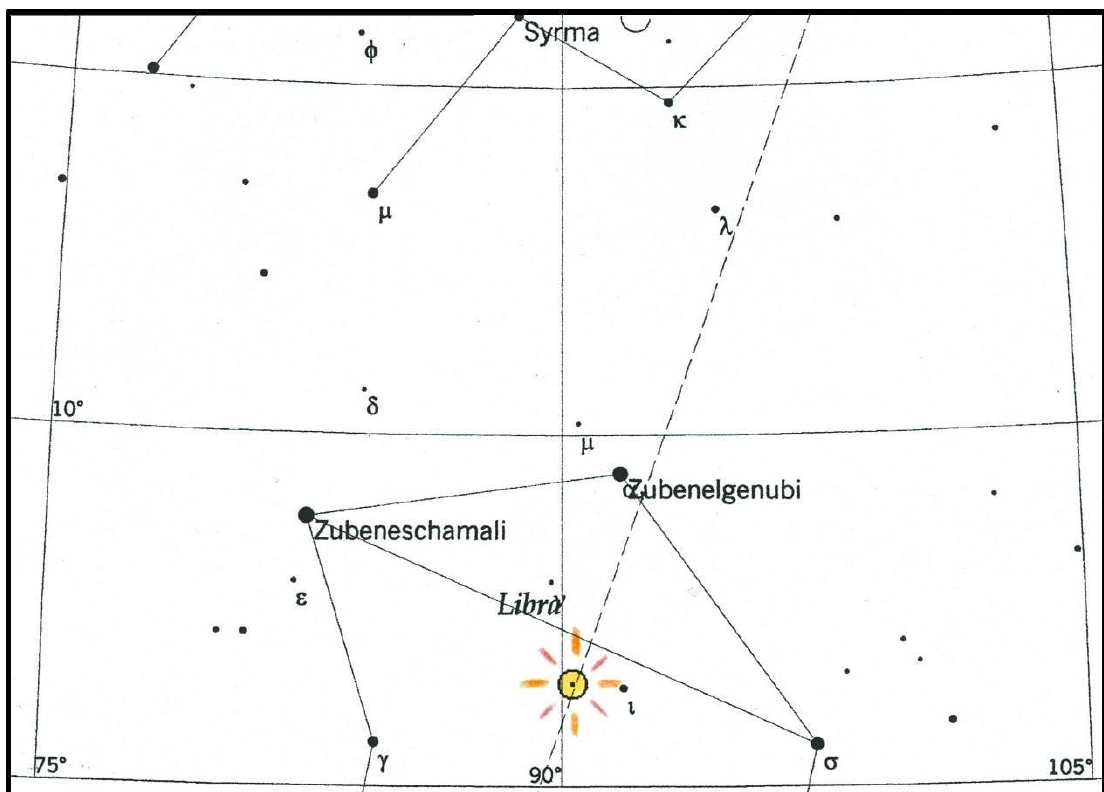
Figure 29. The Autumnal equinox sunrise in the constellation of Libra in 2000 BCE.